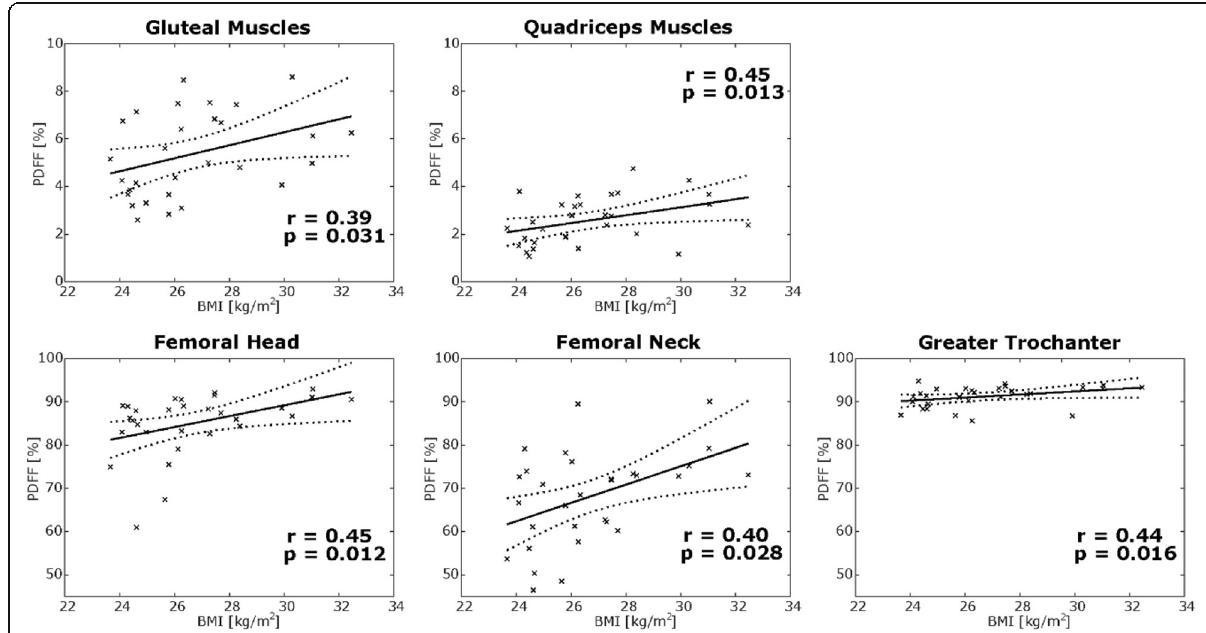
Fig. 4 Scatter plots and linear fit (represented by the continuous line) of BMI versus PDFF of the two muscle compartments ( upper row ) and three femoral compartments ( bottom row ). The areas between the dotted lines represent the 95 % confidence intervals of the best linear fit. BMI , Body mass index; PDFF , Proton density fat fraction